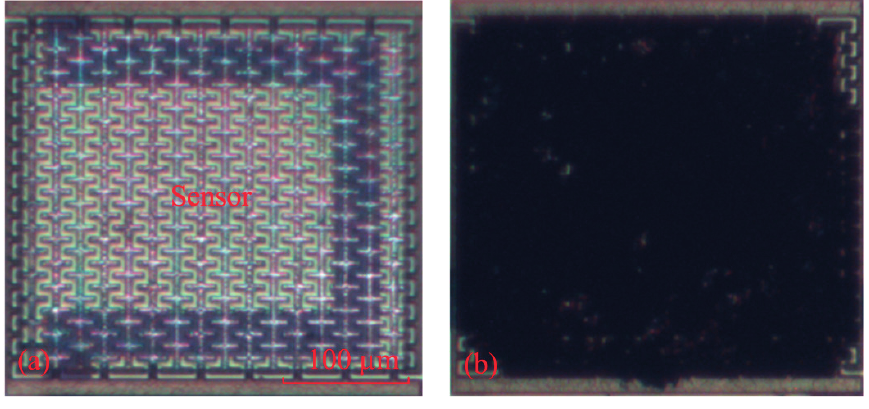
Figure 8. Optical image of the humidity sensor: ( a ) before the post-process; ( b ) after the